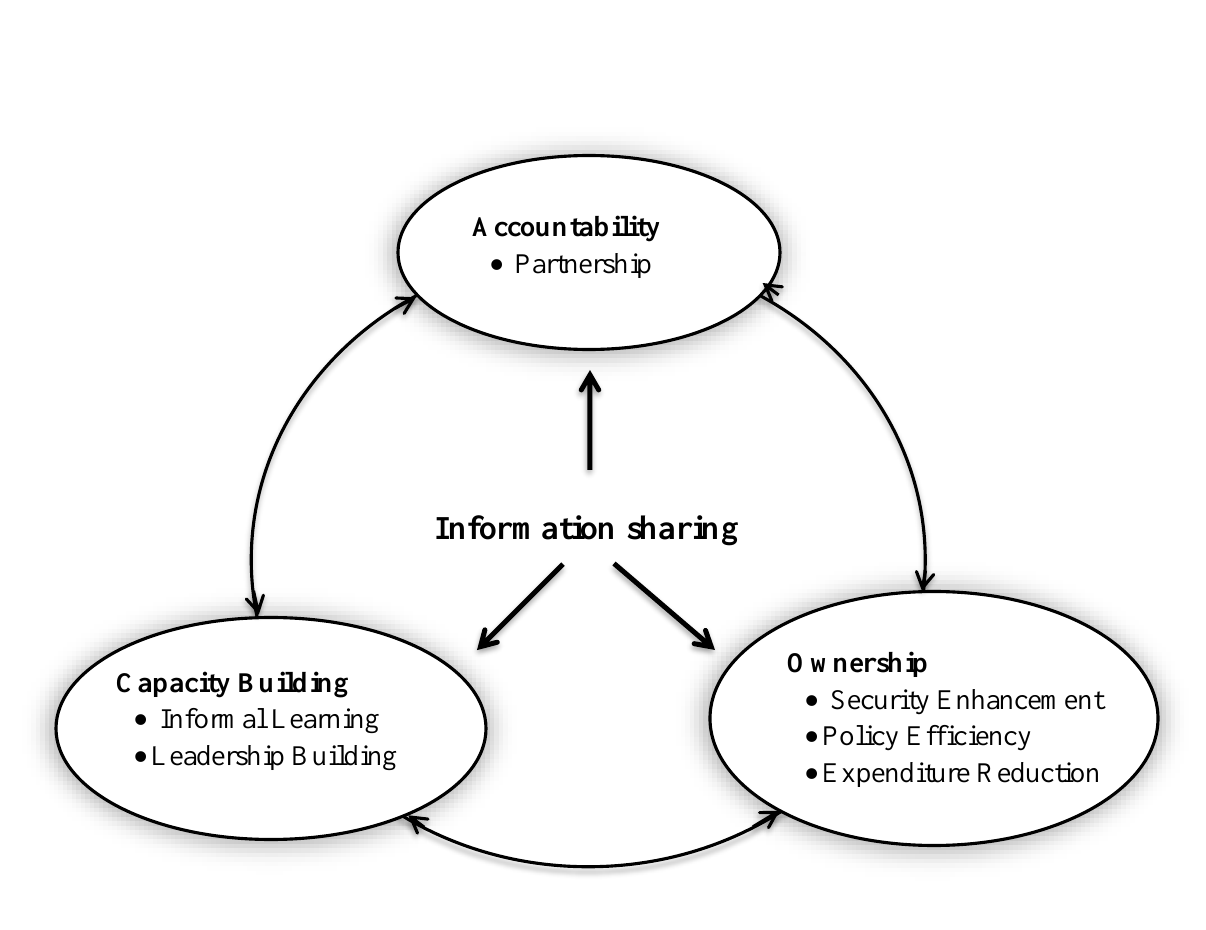
Figure 1: An illustration of tenant participation as understood and rationalized by community housing